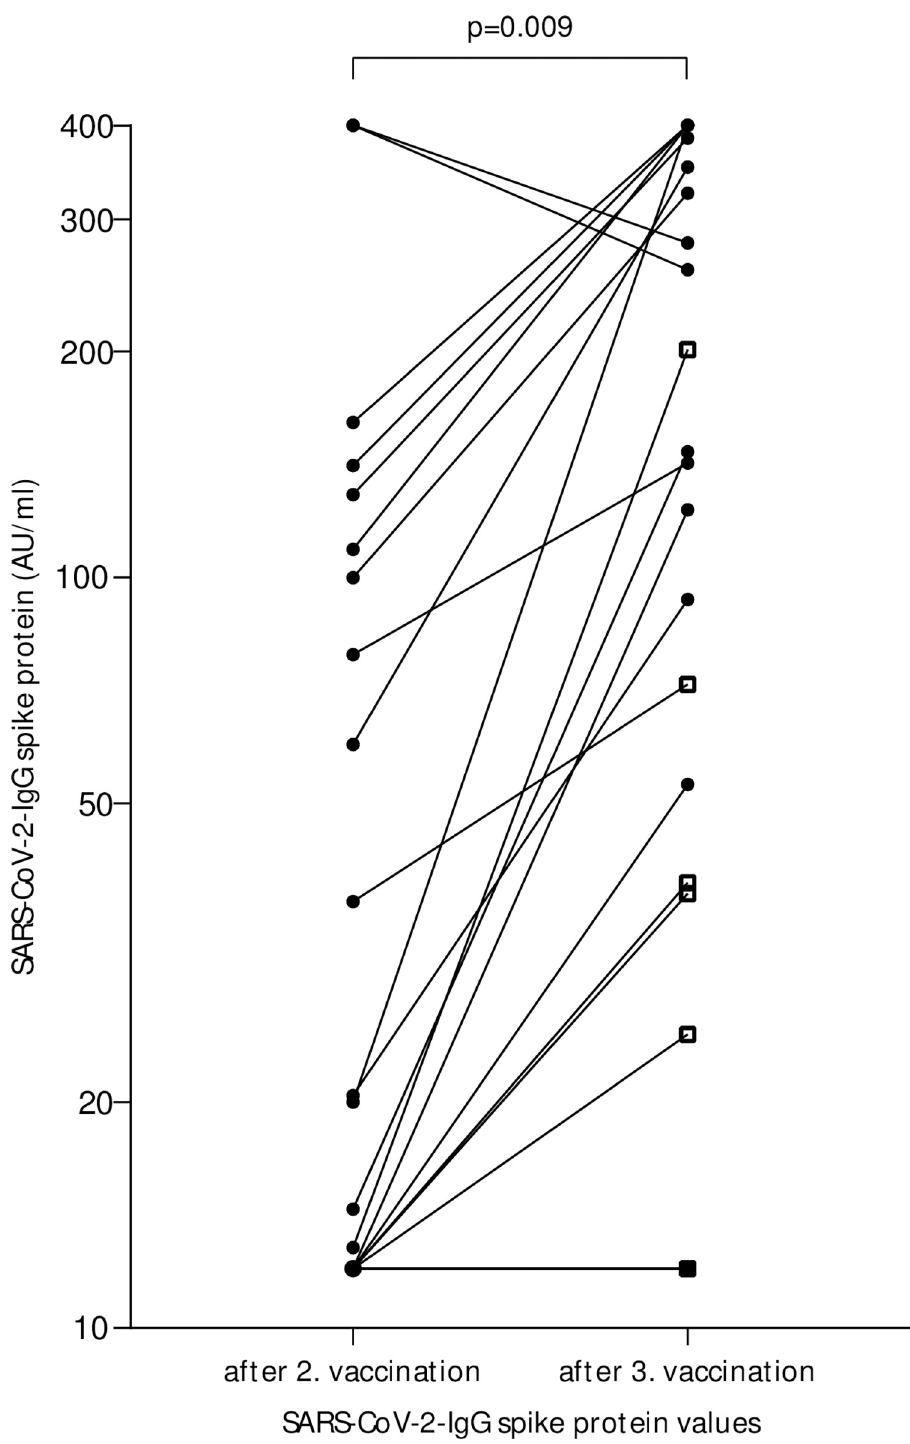
Fig 3. Anti-S quantity after 3. vaccination. Data of SARS-CoV-2-IgG spike protein values of 22 patients with a third mRNA vaccination, including 7 persons under immunosuppressive drugs. In the two subjects with decreasing SARS-CoV-2-IgG spike protein levels despite third vaccination, laboratory analysis was not performed until 4 months after the third vaccination. Subjects under immunosuppressive treatment are marked with square. The p value was calculated by Mann-Whitney